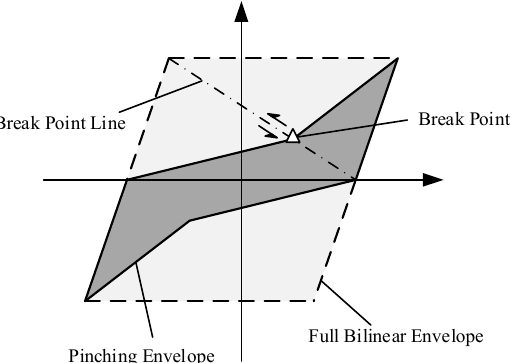
Figure 4. Diagram of the pinching envelope of the pinching model.